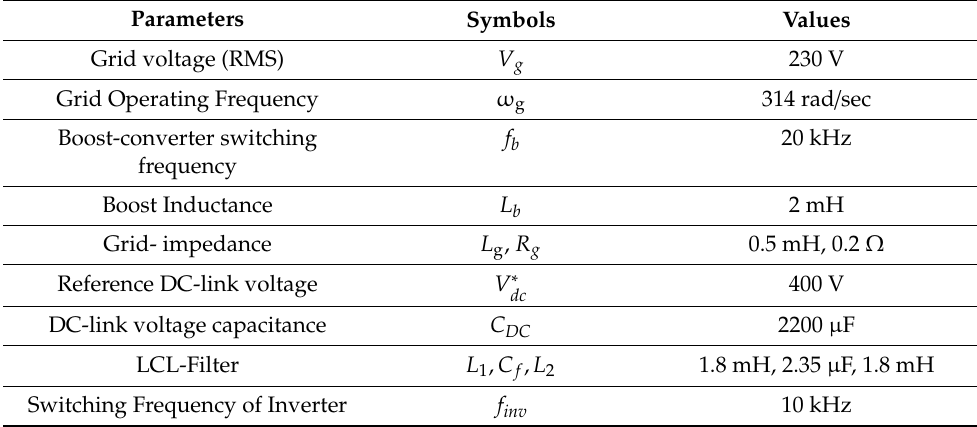
Table 1. Rated parameters of the 3 kW grid-connected photovoltaic model.